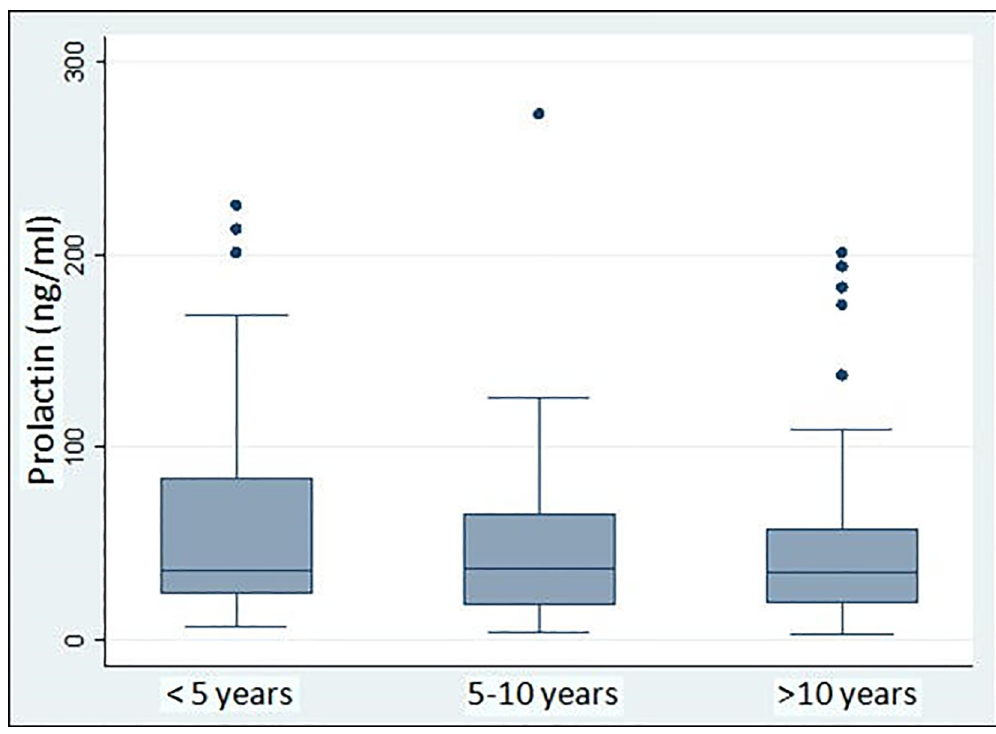
Fig 3. Duration of psychosis and prolactin